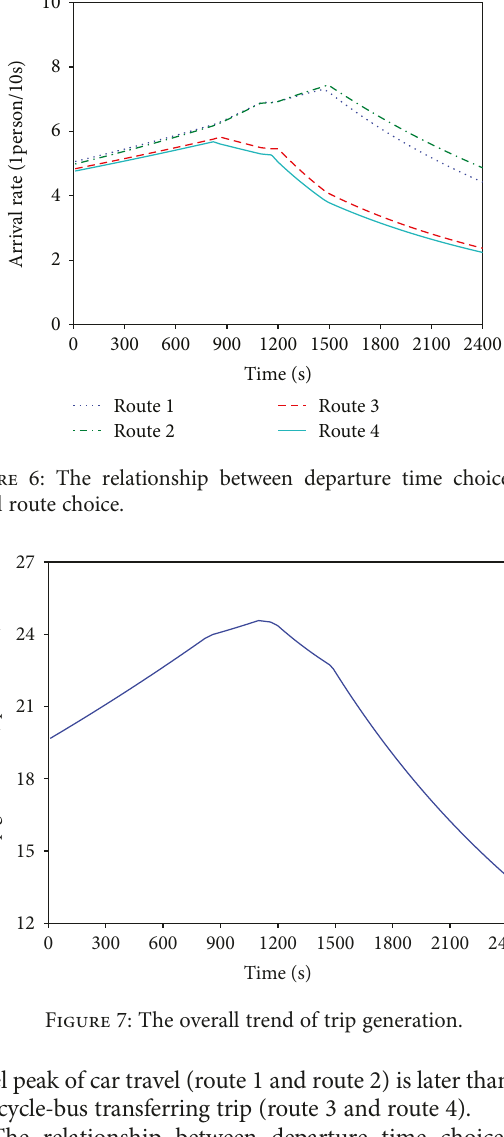
Table 3: Valid route set.